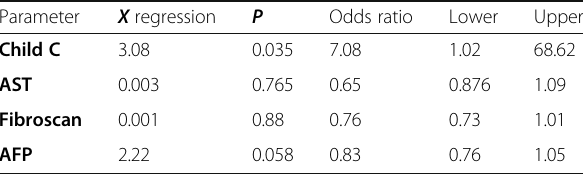
Table 4 Binary logistic regression for significant risk factors or predictors of